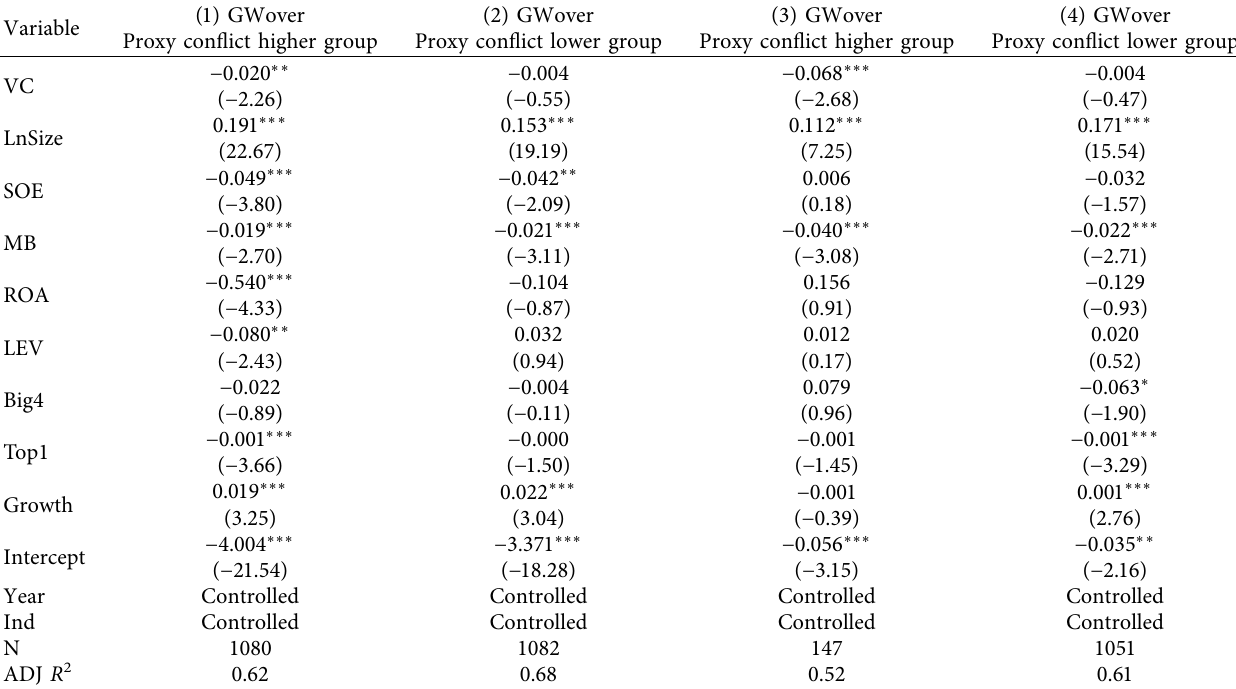
Table 12: Regression results of mitigating agency